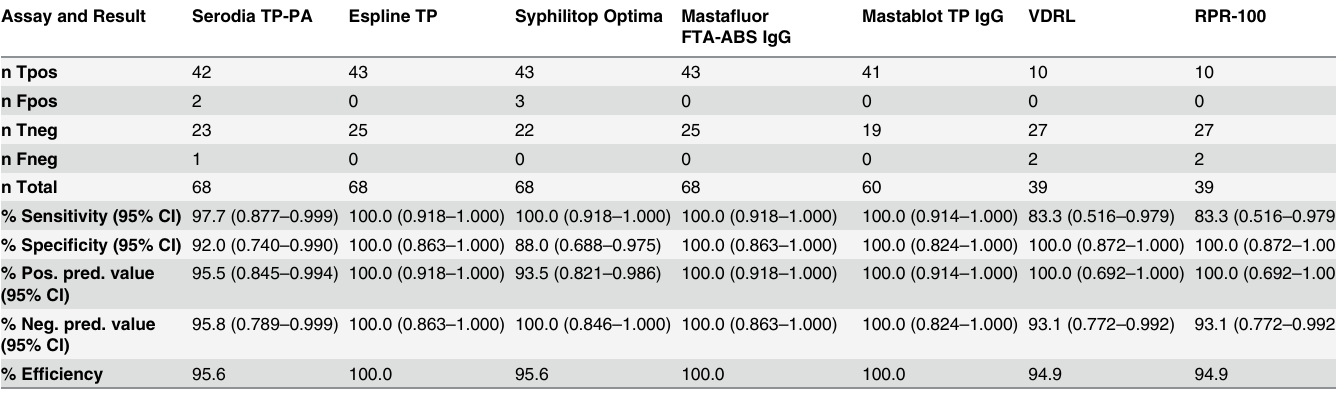
Table 4. Comparison of the serological tests with the consensus of infection status (Table 2).